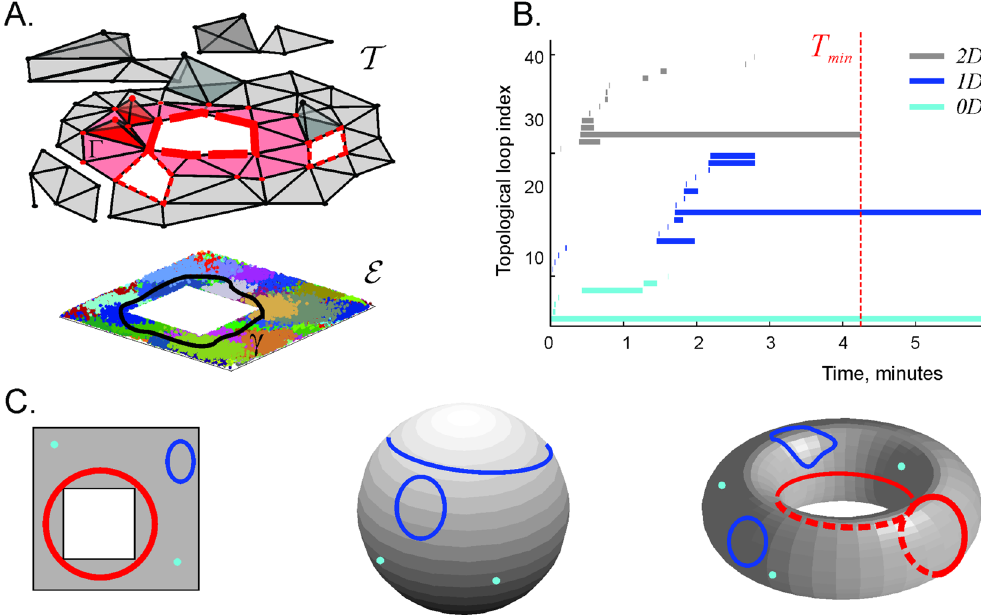
Figure 1. The place cell coactivity complex. ( A ) A simulated rat traverses an environment  with a hole in the middle, covered by place fields (colored regions). Areas where place fields overlap imply place cell co-firing; this is represented by the coactivity complex  . Vertices of  correspond to active neurons, links to pairs of coactive neurons, etc. Early in exploring the space, the complex contains gaps, or transient topological noise, that are filled in with further exploration over time. The hole in the middle of  corresponds to the central hole in  . The non-contractible closed chain of pink simplexes represents the cell assemblies ignited along one path the animal traverses (loop in  ). ( B ) Timelines of zero-dimensional (0 D , cyan), one-dimensional (1 D , blue) and two-dimensional (2 D , gray) topological loops in  . The number of 0 D , 1 D and 2 D lines at every moment defines the Betti values, b 0 , b 1 and b 2 . As long as a given 0 D loop persists,  contains the corresponding connected space (a gray triangle in panel A), a 1 D loop represents a noncontractible hole and a 2 D loop represents a bubble in  . In the illustrated case, the 0 D spurious loops disappear in 1.5 mins, when  fuses into one piece. The spurious 1 D loops disappear in about 2.8 min, when all the spurious holes in  close up, and the 2 D loops disappear by T min = 4.2 min, at which point  becomes topologically equivalent to  . ( C ) The barcode: topological loops in the environment  , sphere S and torus T . In all three cases, any two 0 D loops (i.e., points) can be matched with one another via continuous displacements. Thus, all 0 D loops are topologically equivalent to a single representative 0 D loop, i.e., = . The 1 D loops are of two types: some contract to a point (blue loops), others are non-contractible due to topological obstructions, e.g., the central hole in  .  , b 1 ( S ) = 0 and b 1 ( T ) = 2. Since the sphere and the torus are 2 D surfaces that loop onto Thus, = b ( ) 1 1 themselves, their second Betti numbers are b 2 ( S ) = b 2 ( T ) = 1.  is also 2 D but it can be contracted to the 1 D rim of the central hole, hence  = b ( ) 0 . Lastly, none of the three shapes extend beyond 2 D , so there are no higher- 2 order Betti numbers. The barcodes